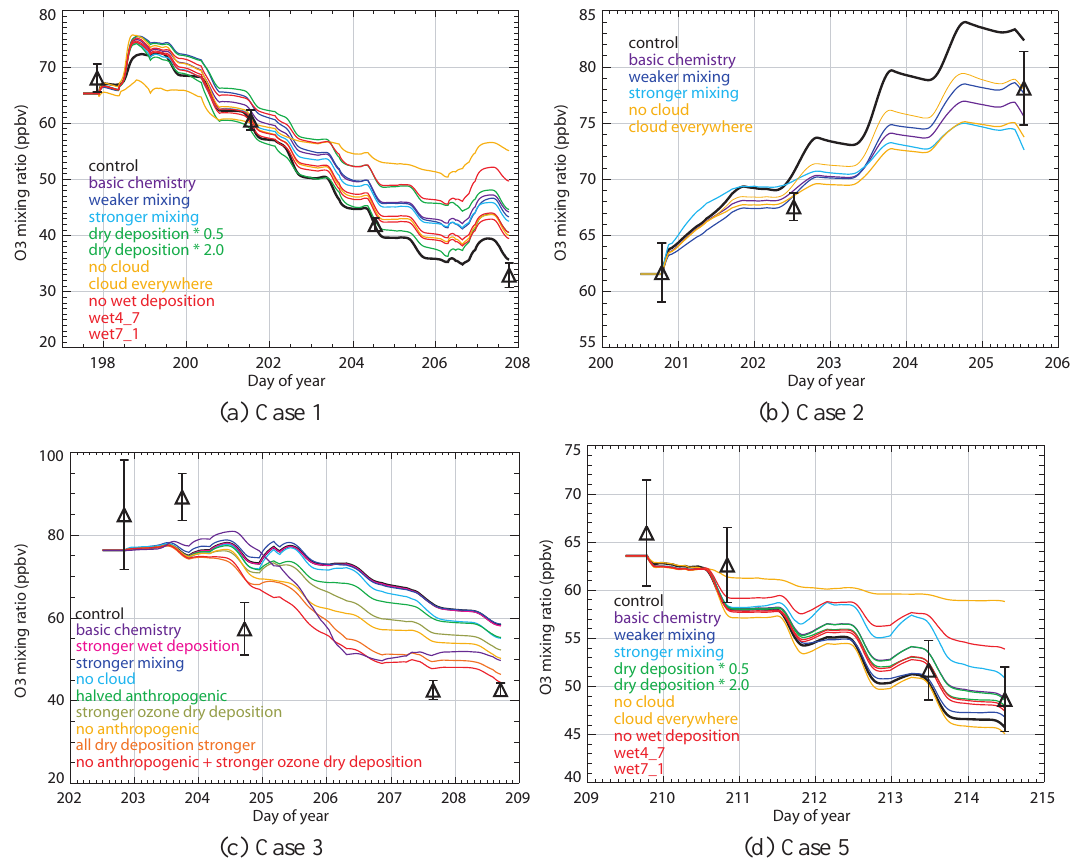
Fig. 5. O 3 mixing ratio along the reference trajectory for each case. The control simulation (black) is shown alongside sensitivity tests as labelled. See Table 1 for details. Mean ± standard deviation aircraft observations taken during the Lagrangian match windows are shown by triangles and error bars. The sensitivity tests for cases 1, 2 and 5 were performed with an earlier version of ensemble CiTTyCAT (with a more basic chemistry scheme, see Sects. 3.2 and 5 for details). The control simulation with the basic chemistry is shown in purple.